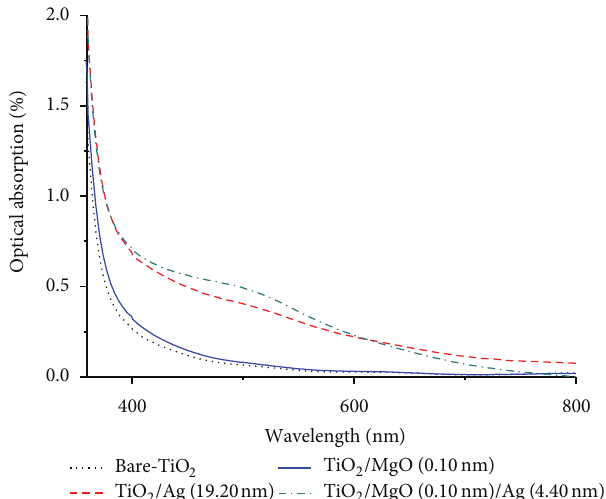
Figure 7: Optical absorption spectra of the bare-TiO 2 film com- pared with the TiO 2 /Ag (19.2nm), TiO 2 /MgO (0.10nm), and TiO 2 /MgO/Ag composite films.